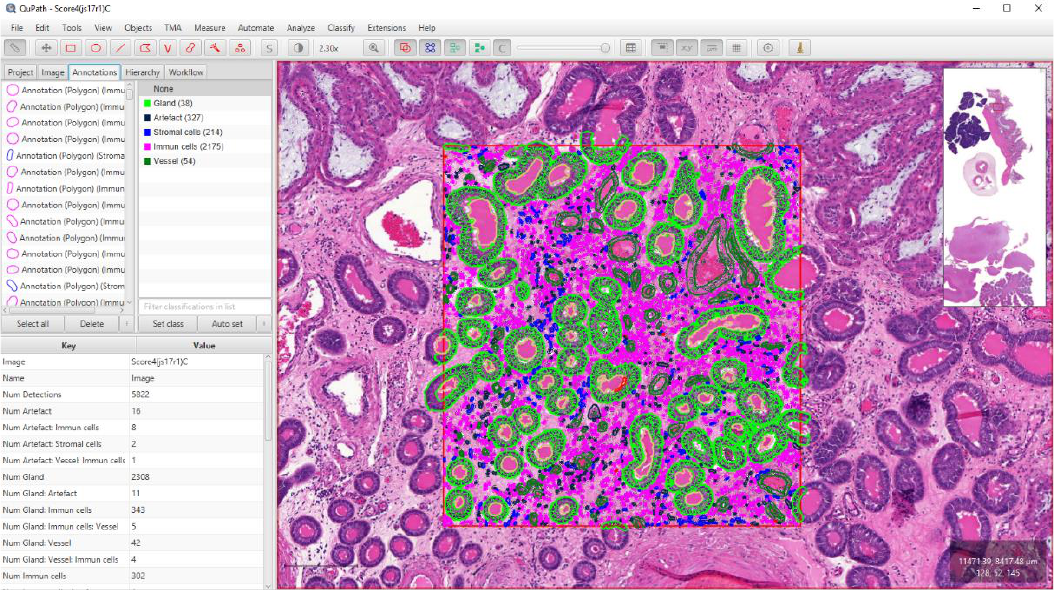
Figure 2. Digital quantification of total inflammatory cells with QuPath software. To train the object classifiers, we manually set the detected cells into the corresponding classes in a 1 mm 2 area.